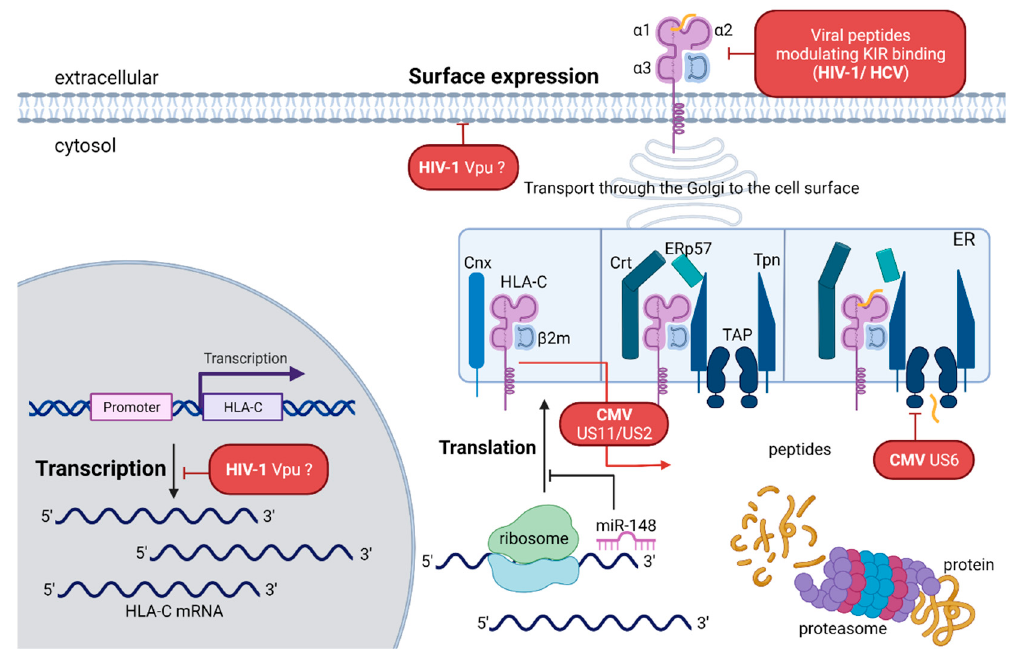
Figure 4. Modulation of HLA-C by viral proteins. Viruses utilize multiple mechanisms to evade immune recognition, including downmodulation of HLA class I molecules or selection of specific peptide variants. Viral escape mechanisms can influence HLA-C expression on the transcriptional, translational, post-translational and protein level. HIV-1 is able to decrease HLA-C surface expression by specific variants of the accessory protein Vpu. CMV encodes different US proteins that target HLA-C heavy chains for proteasomal degradation or block the transport of peptides into the ER. Moreover, HIV-1 and HCV are able to select for specific HLA-C-restricted peptides that modulate the activation of NK cells by altering KIR binding. Created with BioRender.com.